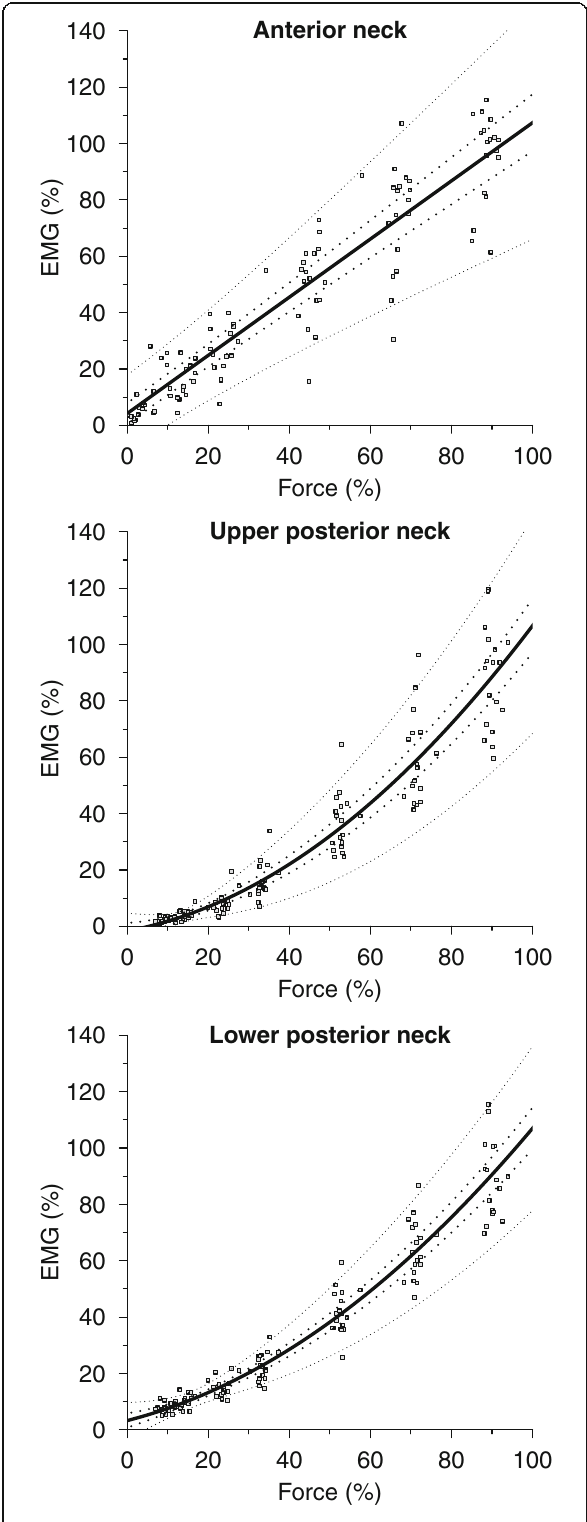
Fig. 3 Final EMG-force relationship models. Solid lines denote the fitted regression line on the sampled data points ( gray squares ). Inner and outer dotted lines mark the 95% confidence interval of the fitted lines computed via the delta method, and the 95% prediction interval generated via parametric bootstrap with 10,000 replicates,